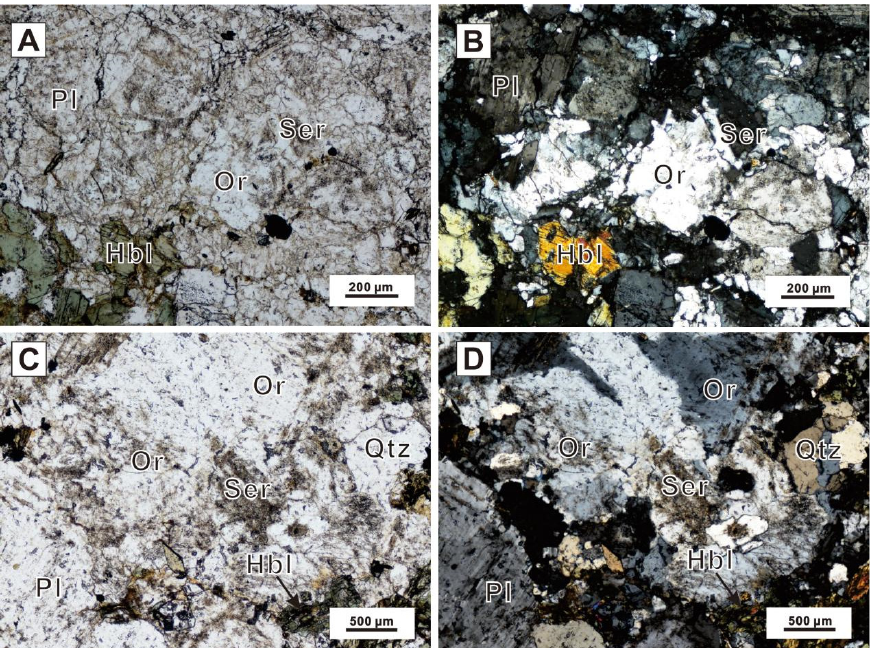
Figure 3. Optical microscopy photomicrographs of the alkaline rocks. ( A , B ) Quartz syenite (21XC03); ( C , D ) Quartz syenite (21XC05). Mineral abbreviations: Pl—plagioclase; Or—orthoclase; Hbl—hornblende; Qtz—quartz; Srt—sericite. ( A , C ) plane-polarized light, ( B , D ) cross-polarized light.